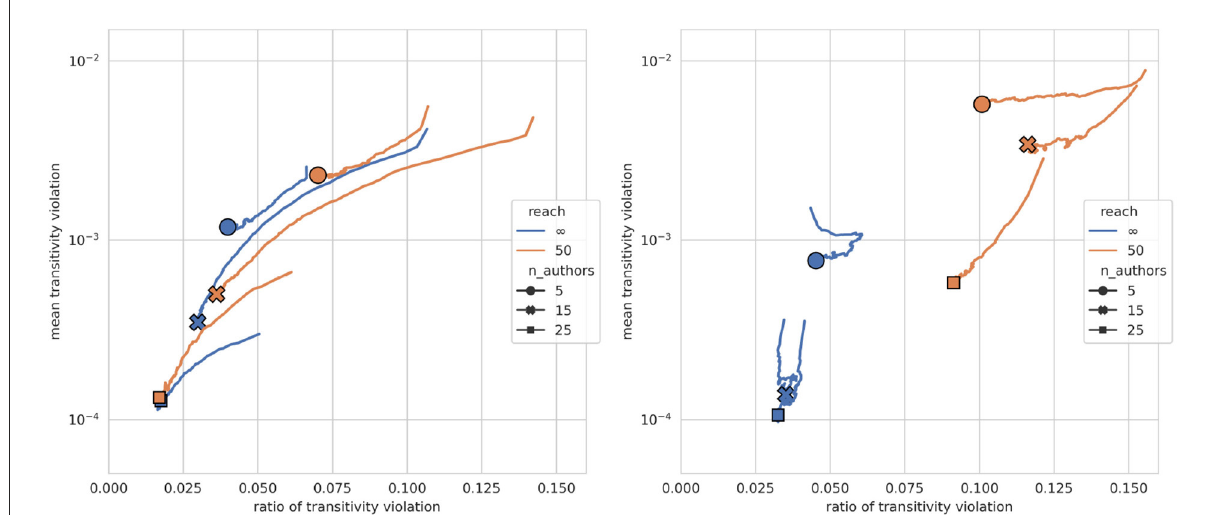
FIGURE3 Transitivity violation trajectories during self-training. Markers indicate the final state reached after self-training. Left : models pre-trained on a corpus with high inter-author diversity ( kendall_tau < 0.055); right : models pre-trained on a corpus with low inter-author diversity ( kendall_tau > 0.055). A trajectory averages over all models pre-trained on a corpus with a given number of agents (indicated by marker style) and a given reach threshold (indicated by